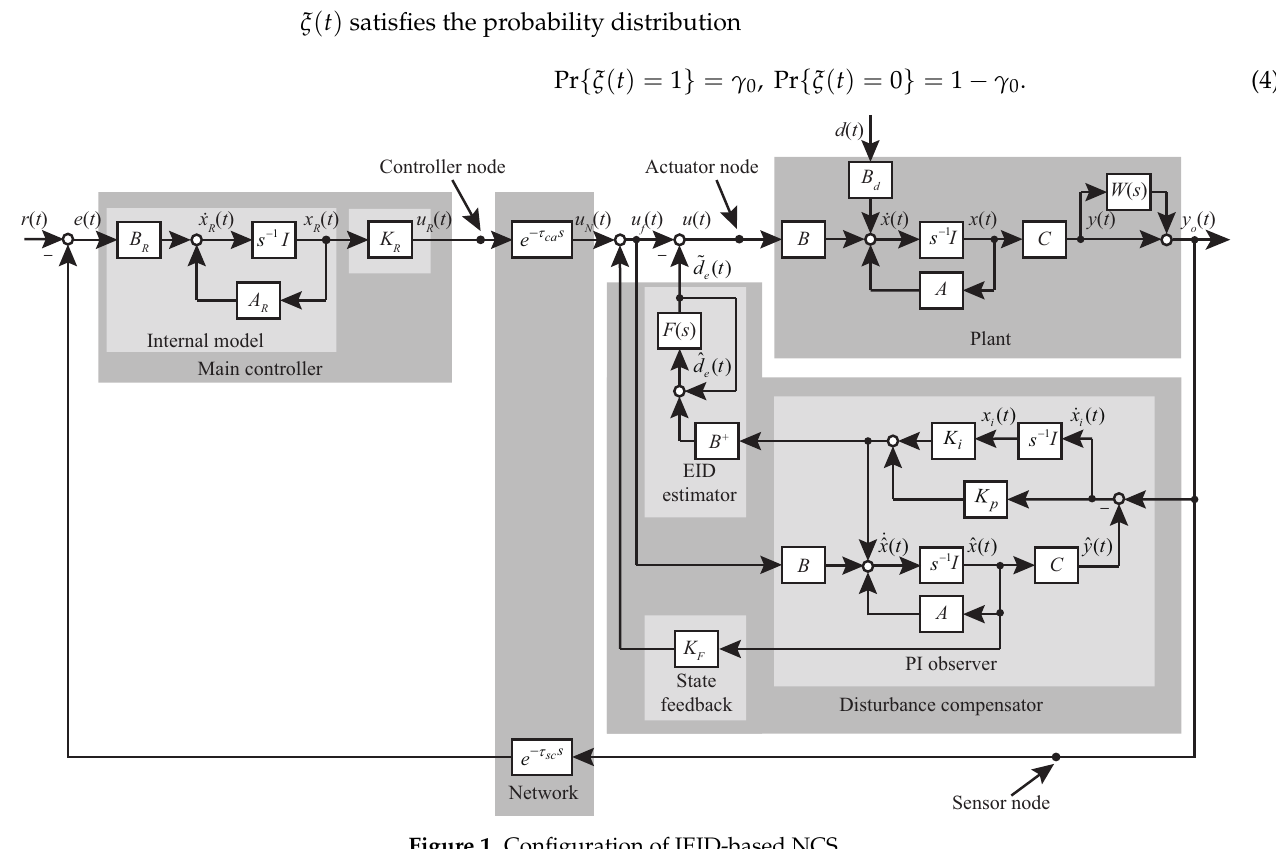
Figure 1. Configuration of IEID-based